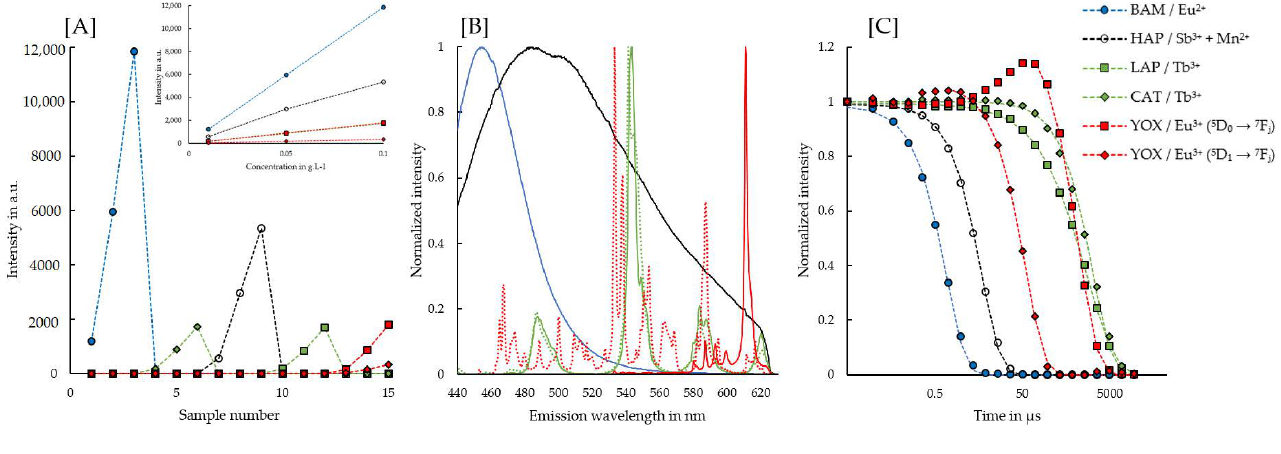
Figure 2. PARAFAC results of samples containing pure phosphors. Standard curves, containing concentrations of 0.01, 0.05 and 0.10 g · L − 1 were measured for BAM (samples 1–3), CAT (samples 4–6), HAP (samples 7–9), LAP (samples 10–12) and YOX (samples 13–15), respectively. All samples were analyzed simultaneously with PARAFAC. ( A ) Distributions of the single PARAFAC components. For YOX, two components were needed to account for the different Eu 3+ emittive levels, i.e., 5 D 0 and 5 D 1 . The inset shows the linear correlation of the phosphors’ luminescence signal versus their concentrations. ( B ) Emission spectrum of each PARAFAC component. On this Figure, the same color code is used as shown in the legend and solid lines are used for LAP and the 5 D 0 → 7 F j transition of YOX, whereas dashed lines are used for CAT and 5 D 1 → 7 F j transition of YOX. ( C ) Luminescence decay of the PARAFAC components. The dashed lines represent the fits of the luminescence decays. The decay of LAP was fitted with a stretched exponential function, whereas the other decays were all fitted with a mono-exponential